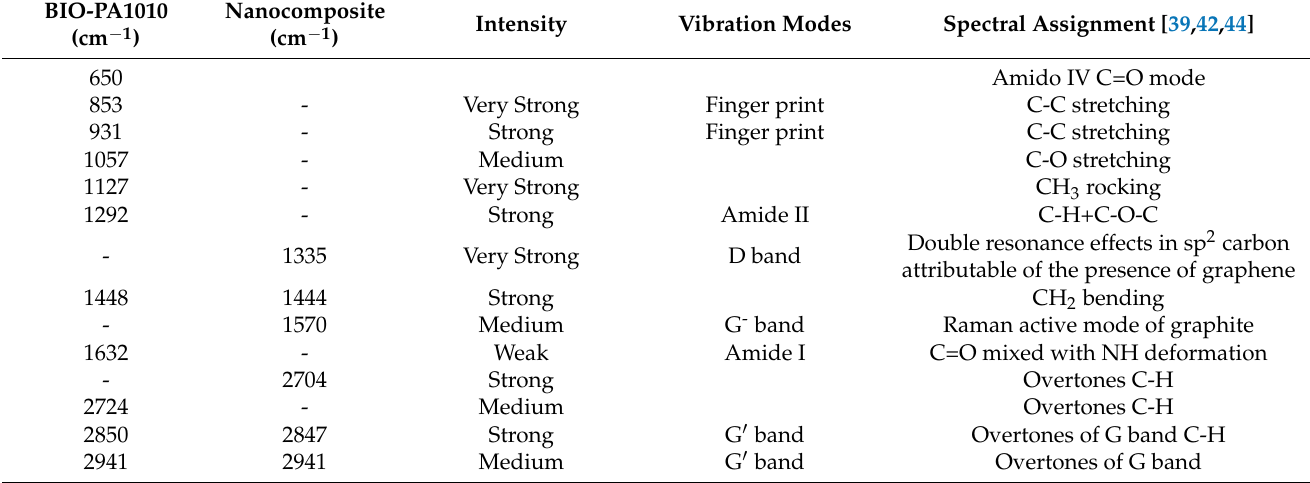
Figure 11. Raman spectra of neat bio-PA1010 and filled with LDH, thermally treated at 80 ◦ C and 145 ◦ C, measured after 1 month ( a ) and of bio-PA1010 nanocomposite filled with graphene type C500-4% thermally treated at 80 ◦ C and 145 ◦ C, measured after 1 month ( b ). Table 1. Main Raman peaks positions of bio-PA1010 and nanocomposites and their proposed assignments. (Adapted with permission from Ref. [42], Copyright © 2016, The Author(s) and